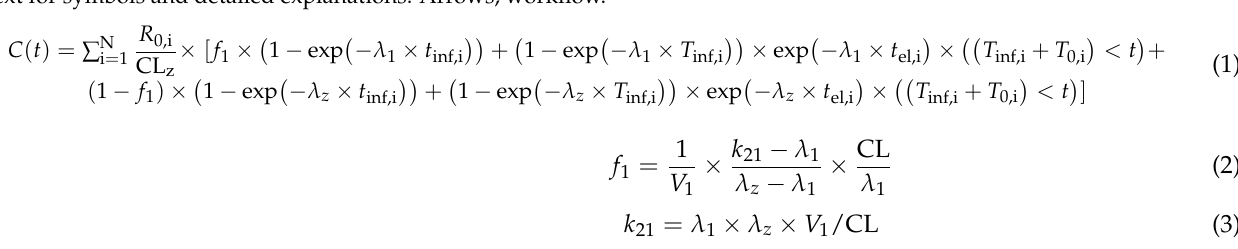
Figure 1. Workflow of the data analysis. Grey, data; blue, model building; yellow, decisions; green, model validation. See text for symbols and detailed explanations. Arrows, workflow.